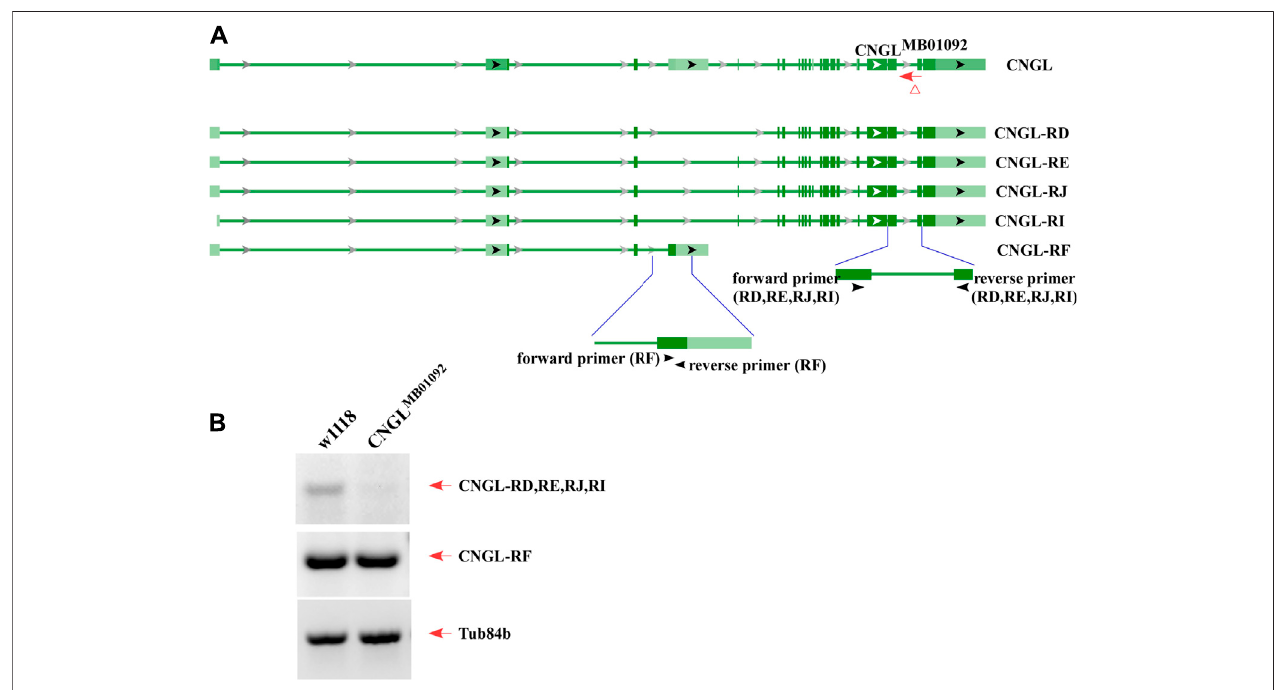
FIGURE 1 | Low level of CNGL transcripts in CNGL MB01092 . (A) Five predicted transcripts of CNGL (CNGL-RD, RE, RJ, RI and RF), two sets of primers and CNGL MB01092 mutant line. (B) RT-PCR was performed on total RNA extracted from whole fl ies of either w1118 or CNGL MB01092 . For a loading control, the cDNA was also ampli fi ed with Tub84b primers. Lower level of CNGL transcripts was observed in the mutant.